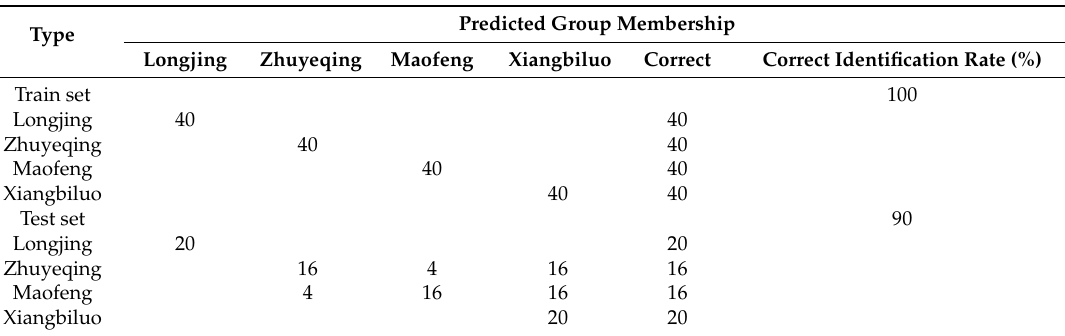
Table 4. Classification results of BP neural network.